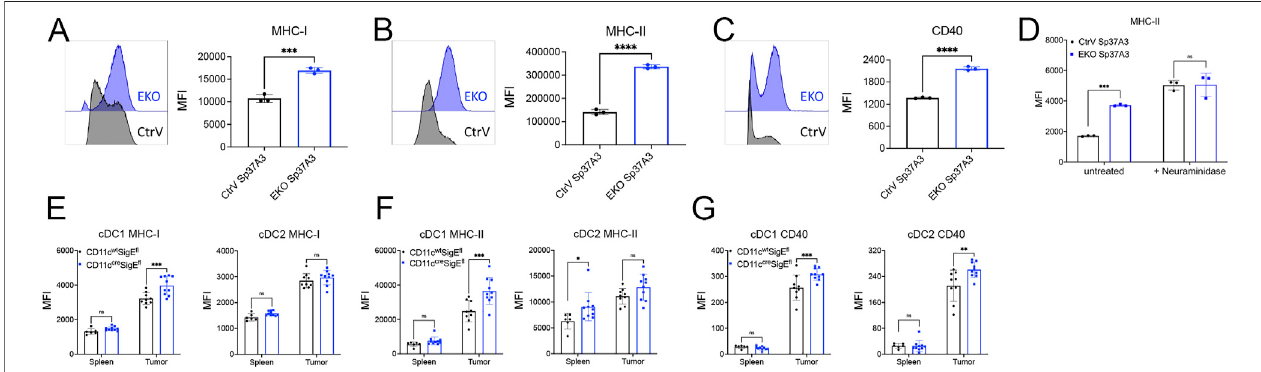
FIGURE 3 | Siglec-E-de fi cient DCs showed enhanced phenotypic maturation. (A – C) Flow cytometry analysis of the expression levels of several DC maturation markersonCtrVSp37A3cells(black)and EKOSp37A3cells(blue),including MHC-I (A) ,MHC-II (B) ,andCD40 (C) . (D) treatment ofCtrVSp37A3 cells(black)and EKO Sp37A3 cells (blue) with neuraminidase and maturation with LPS was measured by the expression of MHC II. (E – G) Maturation markers on spleen and tumor-in fi ltrating cDCsisolated from MC38 subcutaneoustumor models of CD11c cre SigE fl mice (blue) and littermates (CD11c wt SigE fl , black) by fl ow cytometry. Dataare presented asmean(±SD).Two-wayANOVAwasusedfortwo-waycomparisons,andunpaired t testwasusedforone-waycomparisons(* p < 0.0332,** p < 0.0021,*** p < 0.0002, and **** p < 0.0001).